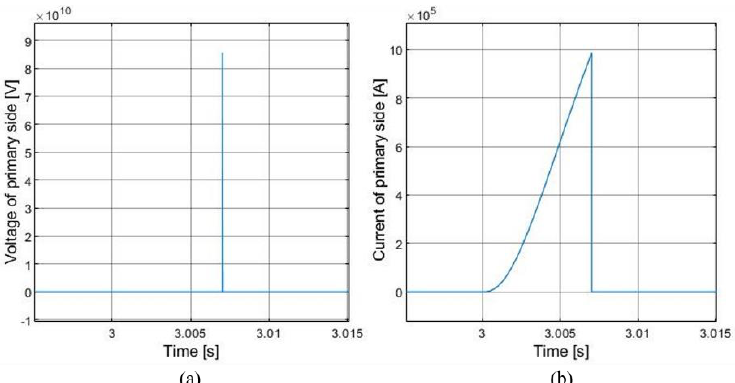
Figure 13. Current and voltage waveform on transformer after the fuse is added: ( a ) voltage waveform; ( b ) current waveform. waveform; ( b ) current